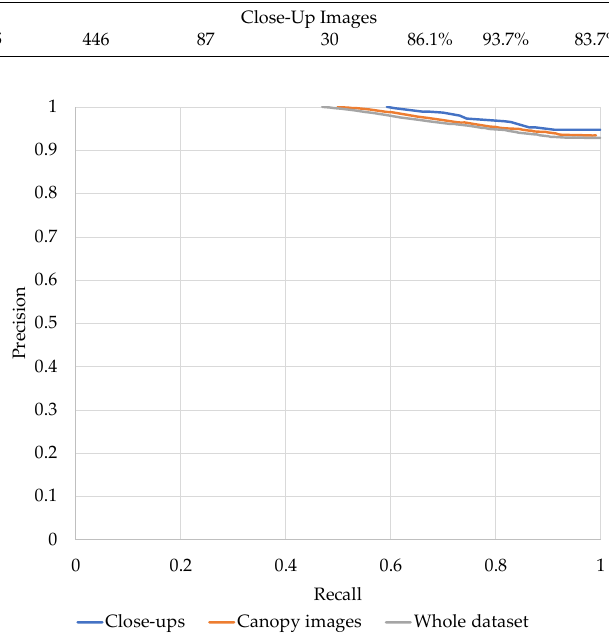
Figure 11. Precision–Recall curve.